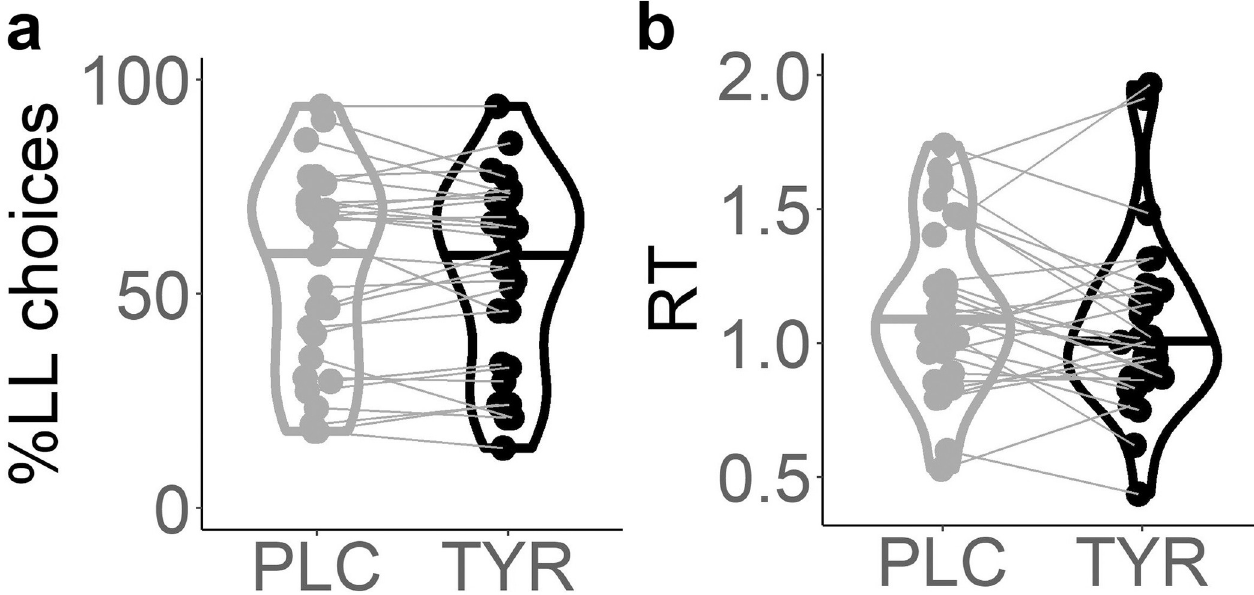
Fig 6. Violin plots of (A) proportions of LL choices following placebo and tyrosine supplementation, and of (B) median response times (RT) in the temporal discounting task per supplementation condition (placebo vs. tyrosine).